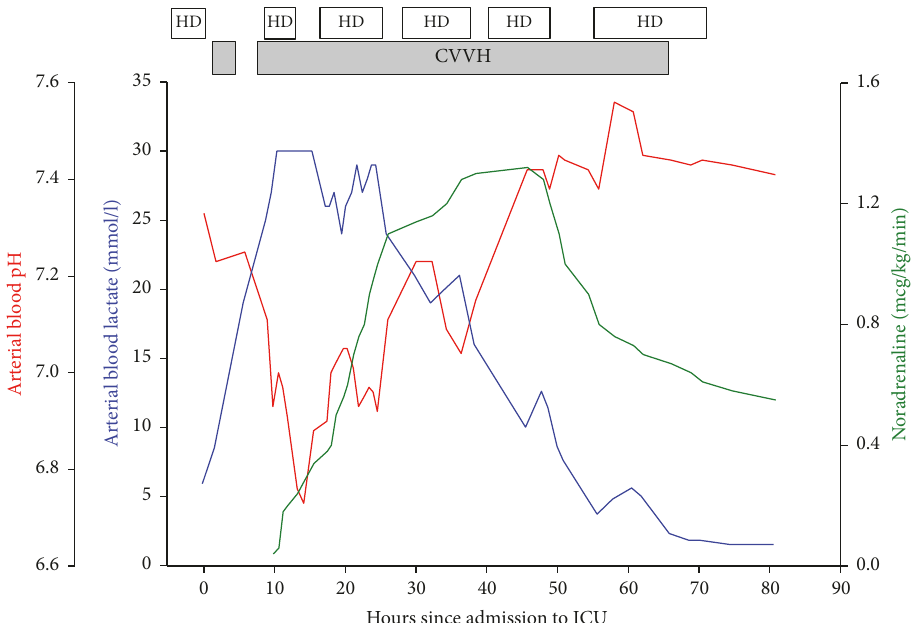
Figure 1: Measurements of arterial blood pH (red) and lactate (blue) together with the infusion rate of noradrenaline (green) in the hours following admission to the intensive care unit (ICU). HD denotes hemodialysis and CVVH continuous venovenous